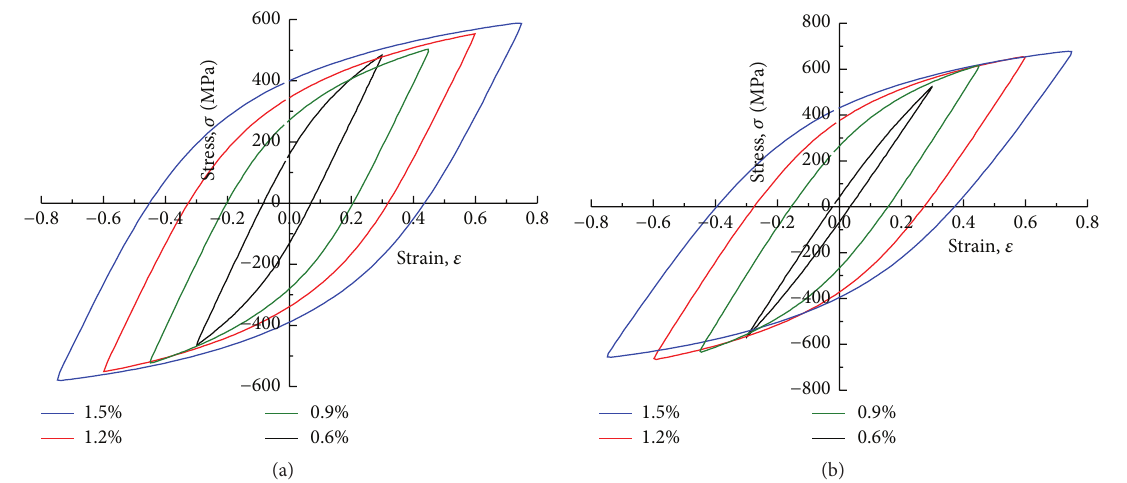
Figure 7: Stable hysteresis loops for a half-life at each total strain range for (a) Alloy 617 BM and (b) Alloy 617 WJ.